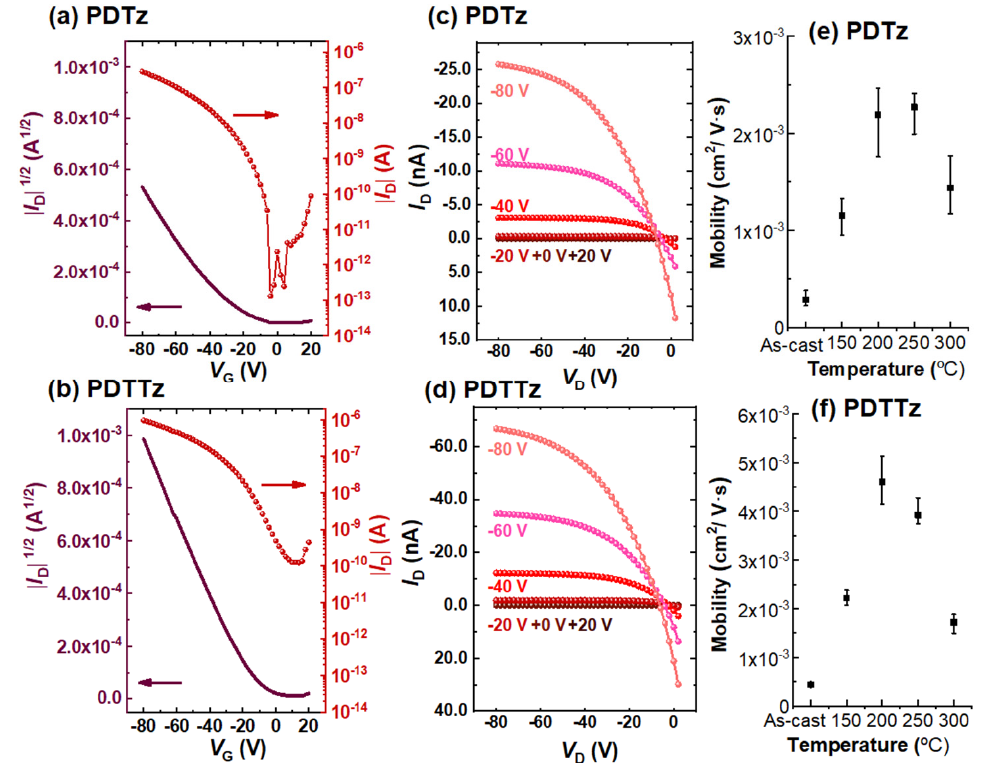
Figure 2. ( a ) Layer structure of OTE devices. ( b ) Seebeck coe ffi cient, ( c ) conductivity, and ( d ) power factor of PDTz and PDTTz devices.